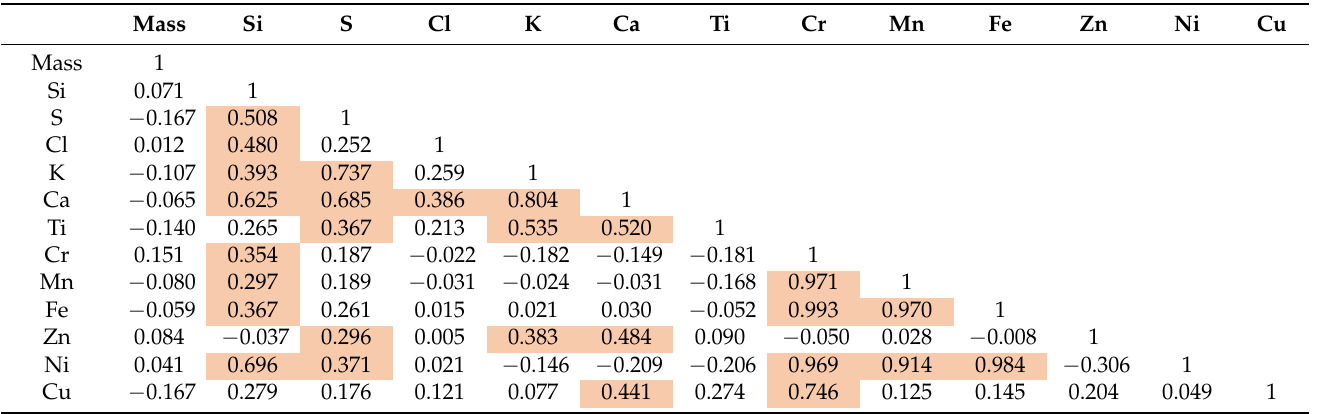
Table 7. Pearson’s correlation coefficients relating the mass of PM 10 and the elements concentrations of PM 10